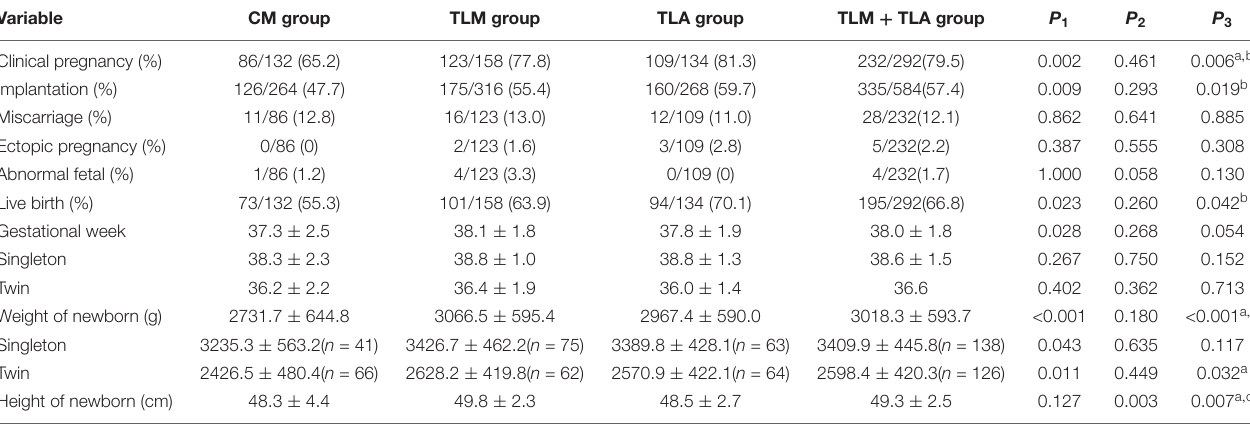
TABLE 3 | Clinical outcomes and perinatal outcomes for the procedure-completion patients in three groups.